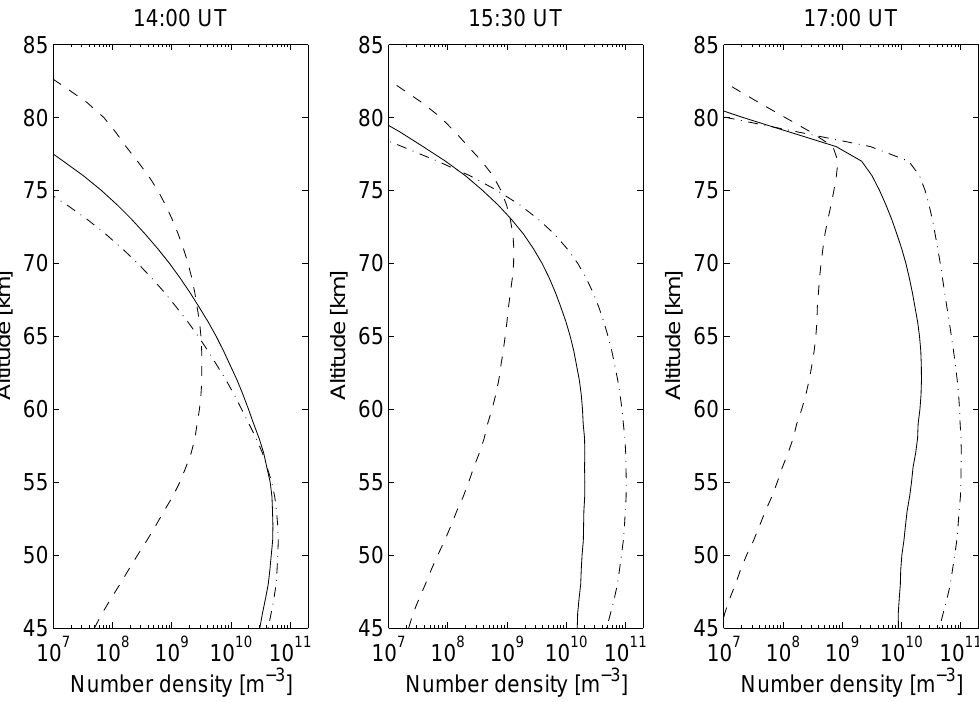
Fig. 7. Modelled density profiles of the main negative ions before, during, and after the sunset of 23 October. Dashed line, solid line, and dash-dot line indicate O − , CO − , and NO − , respectively. 2 3 3